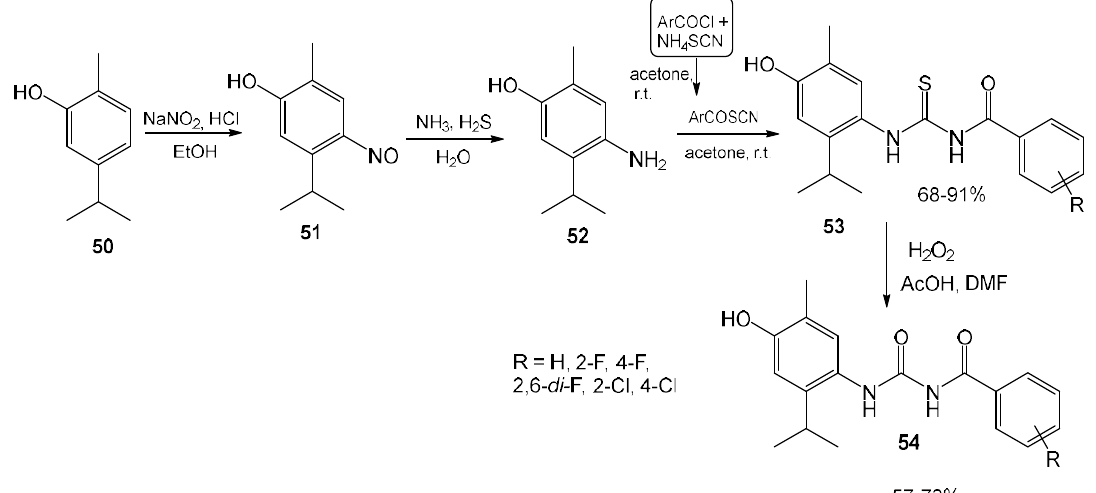
Fig. 16. Structural modification of carvacrol for the development of effective plant protection products of polyvector